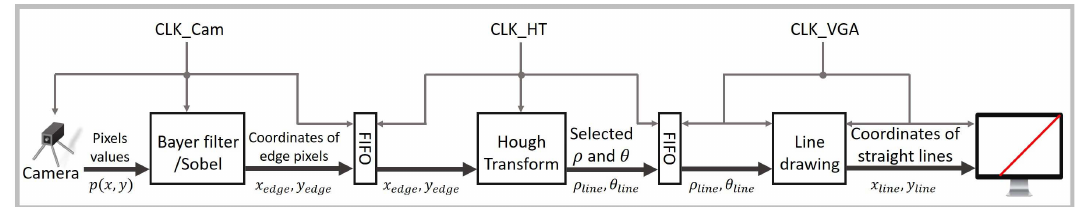
Figure 7. Prototype system for straight-line detection in video